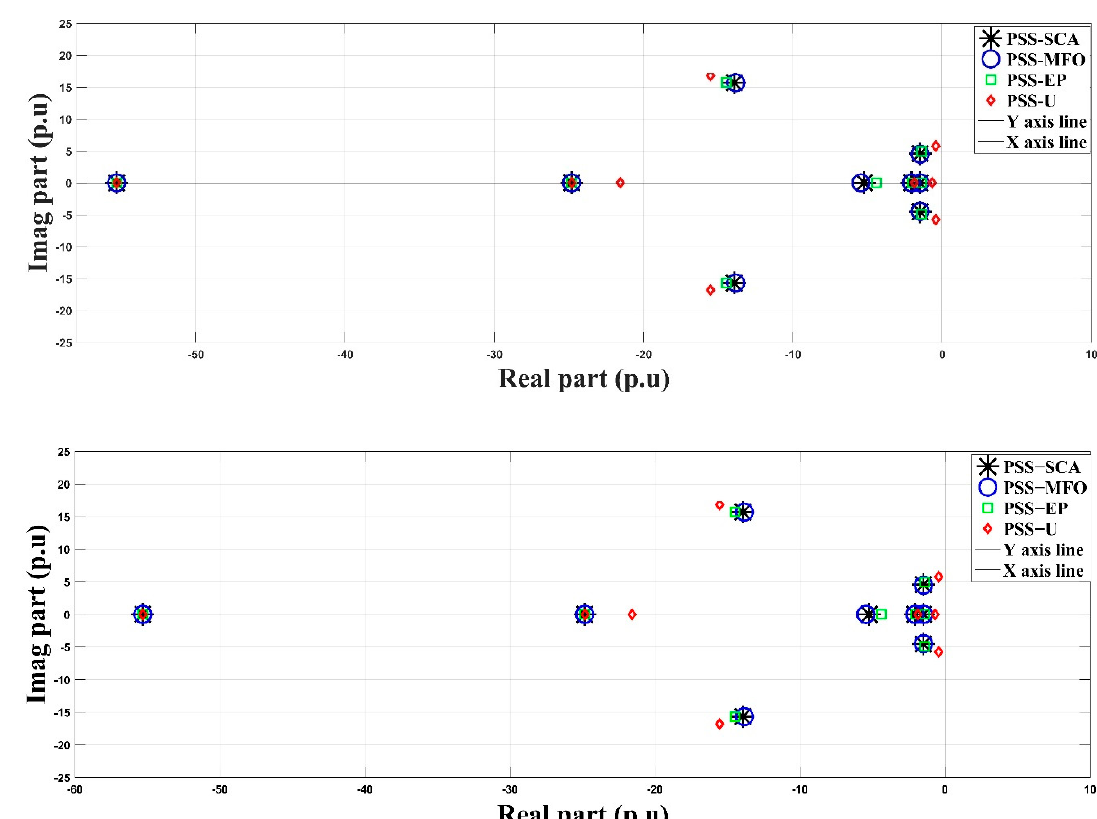
Figure 12. Eigenvalues distribution of PSS-SCA, PSS-MFO, PSS-EP, and PSS-U for case 3.